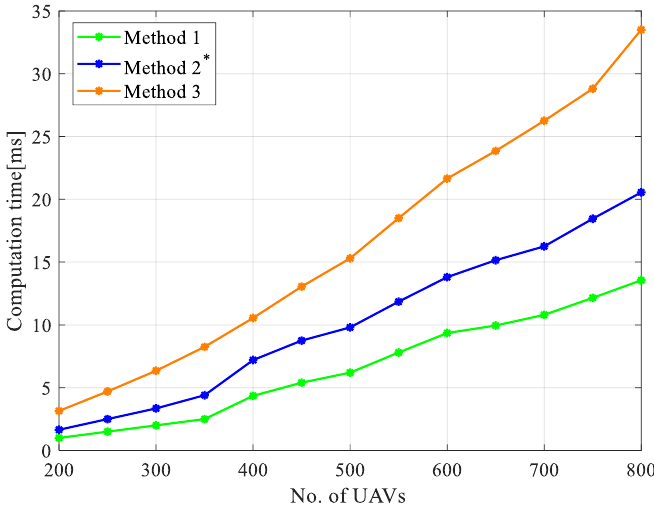
Figure 10. Computational time comparison between Method 1, Method 2* and Method 3.